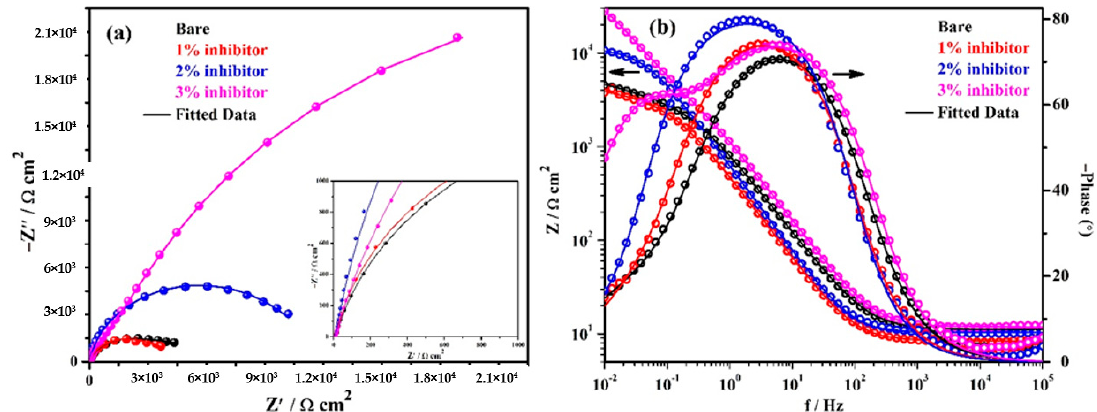
Figure 6. EIS plots. ( a ) Complex plane impedance and ( b ) Bode spectra of steel rebars after 120 h of exposure in SCP + 3.5 wt% NaCl solution with and without exposure in SCP + 3.5 wt% NaCl solution with and without inhibitor.